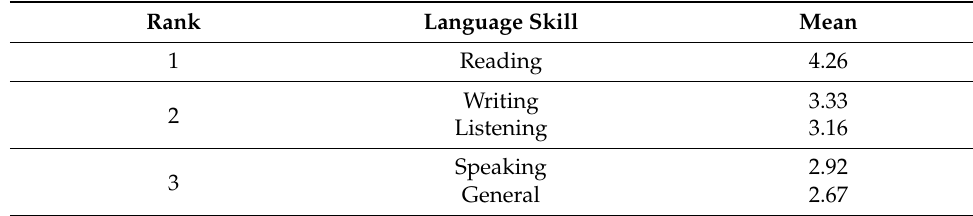
Table 5. Relevance of language skills.